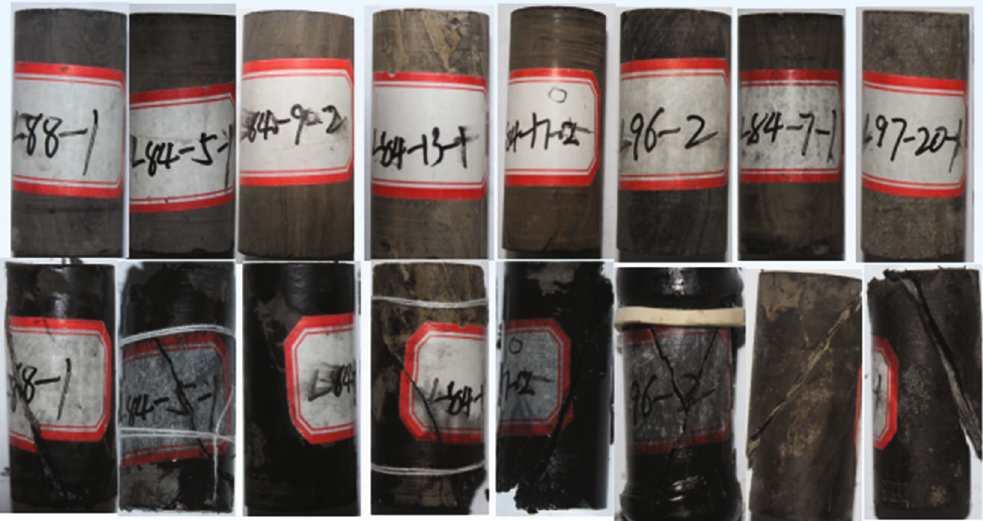
Figure 5: Natural core samples of the study block (Leijia).